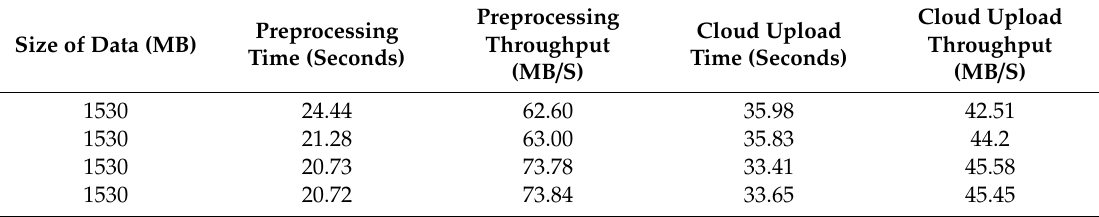
Table 3. Jetson (Fog) device throughput